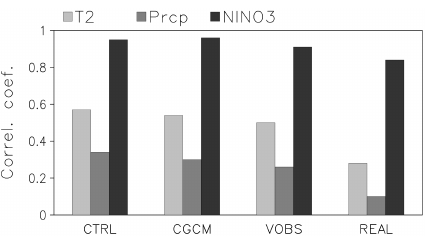
Figure 6. Temporal correlation between the analysis and the truth for each experiment for 1970–1999. The values for temperature and precipitation are the global mean of the temporal